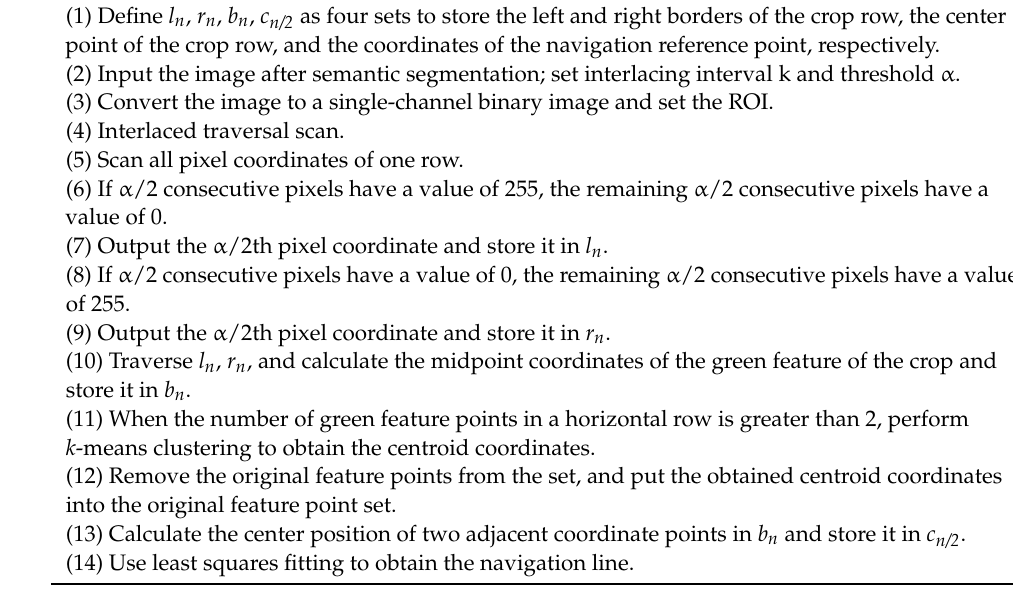
Algorithm 1. Adaptive Midpoint Fitting